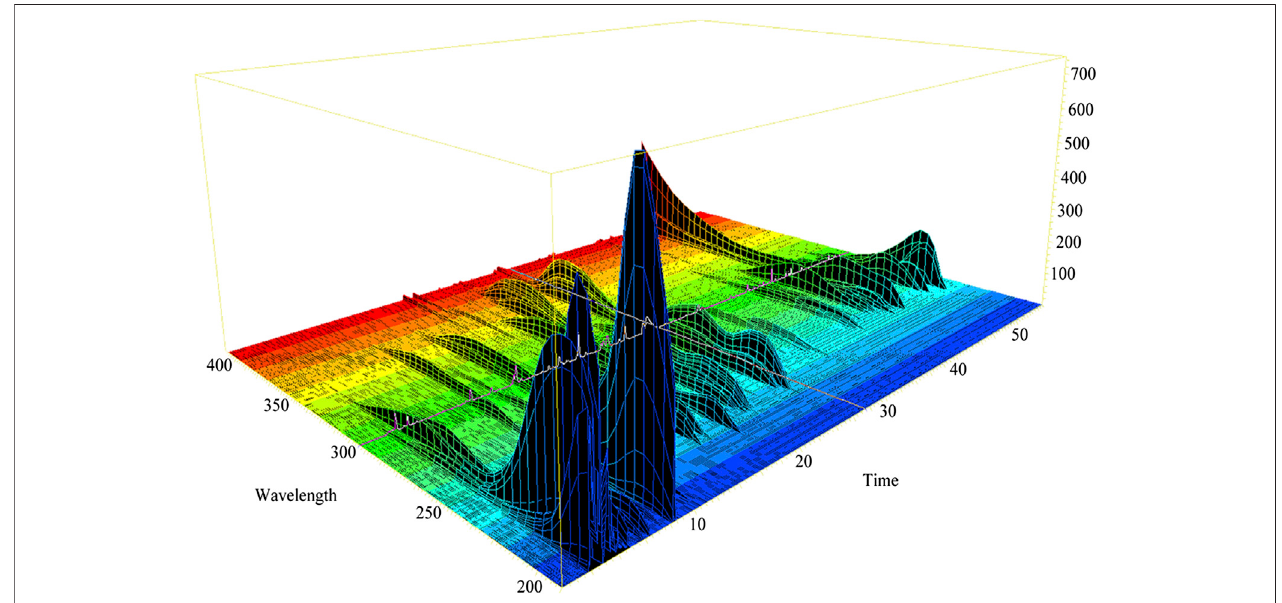
FIGURE 1 | The 3D-HPLC chromatogram of GDD.